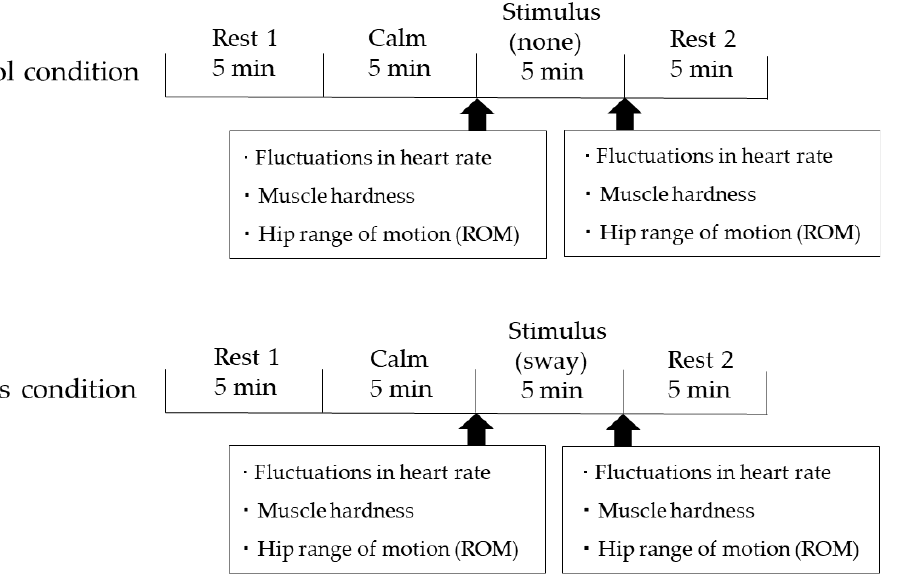
Figure 3. Details of each condition and timing of the measurements. The control conditions were Rest 1 (5 min), Calm (5 min), Stimulus (none) (5 min), and Rest 2 (5 min) (total of 20 min). The sway stimulus conditions were Rest 1 (5 min), Calm (5 min), Stimulus (sway) (5 min), and Rest 2 (5 min) (total of 20 min). The fluctuations in heart rate were measured during the Calm and Sway segments of each protocol. We measured the muscle hardness and the hip ROM before and after the second Calm segment under the control conditions, as well as before and after the Sway segment under the sway stimulus conditions.